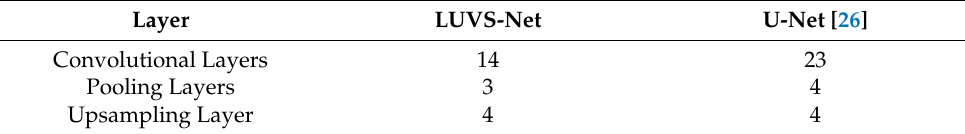
Table 2. Layers in LUVS-Net. Layer LUVS-Net U-Net [26] Convolutional Layers 14 23 Pooling Layers 3 4 Upsampling Layer 4